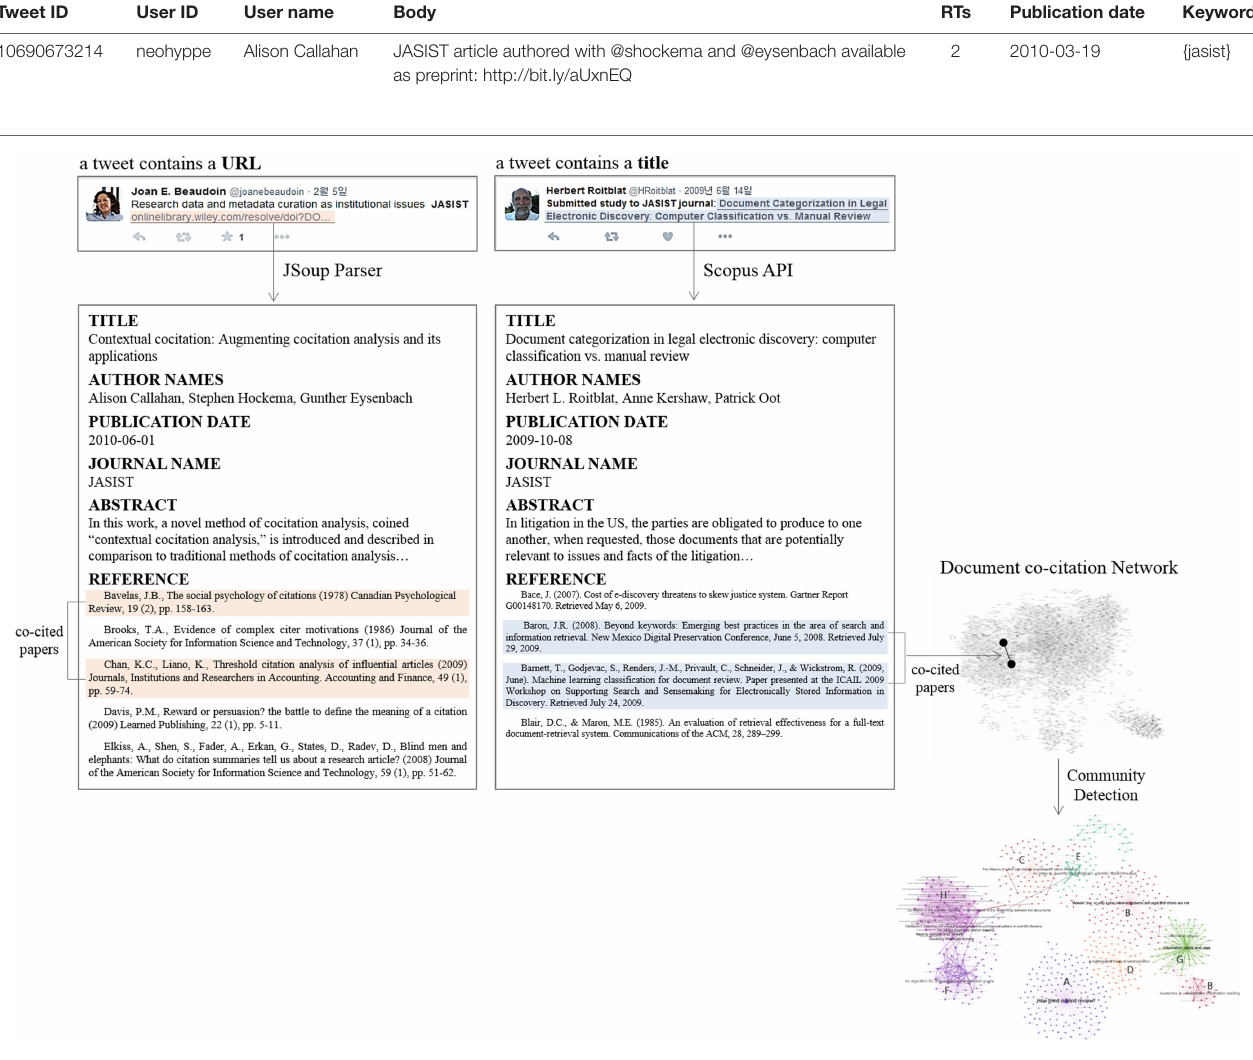
TaBle 1 | Tweet instance.